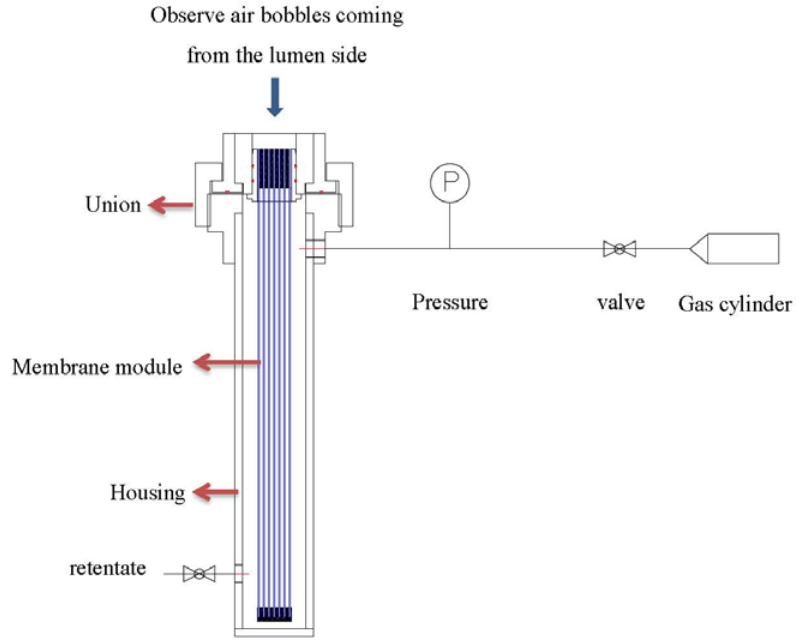
Figure 2. Leaking test of hollow fiber